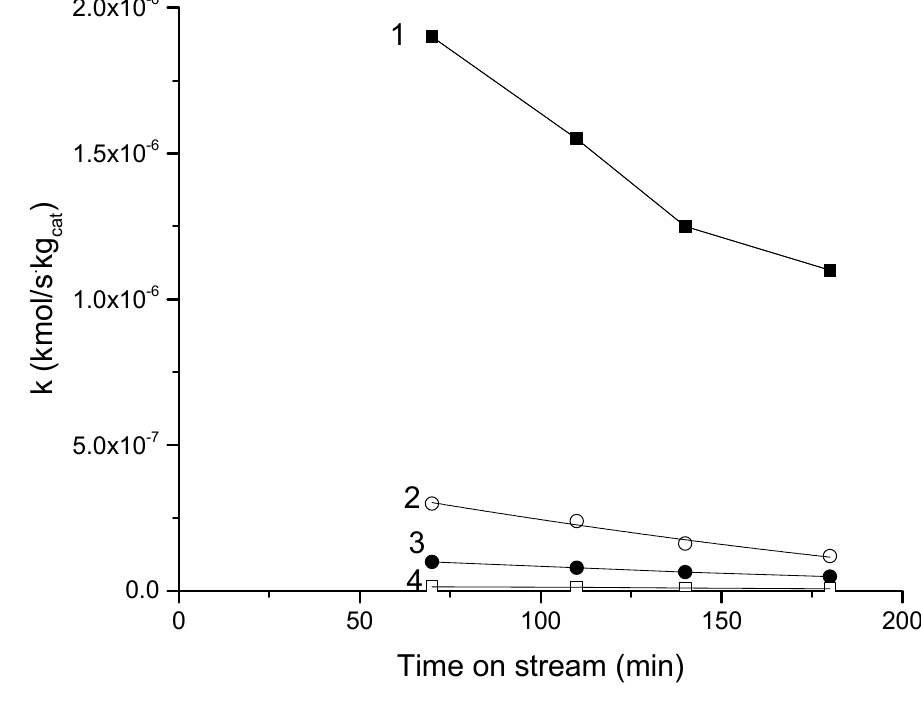
Figure 22. Decrease of the kinetic constants as a function of time on stream in the HDO of guaiacol at 400 ◦ C under 1 bar over Fe/SiO 2 adapted from ref. [33]. The reaction mixture contained also 50% H 2 , 5% CO 2 , 2.5% CO and 2.5% H 2 O. Notation: (1) guaiacol to products, line fitting: = 2.85 · 10 − 6 e − 4.61 · 10 − 3 x , (2) guaiacol to cresol, line fitting : y = 4.93 · 10 − 7 e − 7.29 · 10 − 3 x , (3) phenol to benzene, line fitting: y = 1.37 · 10 − 7 e − 4.85 · 10 − 3 x , and (4) cresol to toluene, line fitting: y = 2.81 · 10 − 8 e − 5.03 · 10 − 3 x .